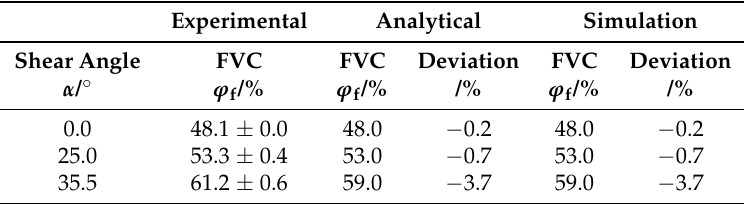
Table 4. Comparison of fiber volume content results for sheared preforms with n L = 6 and an assumed laminate thickness of t =